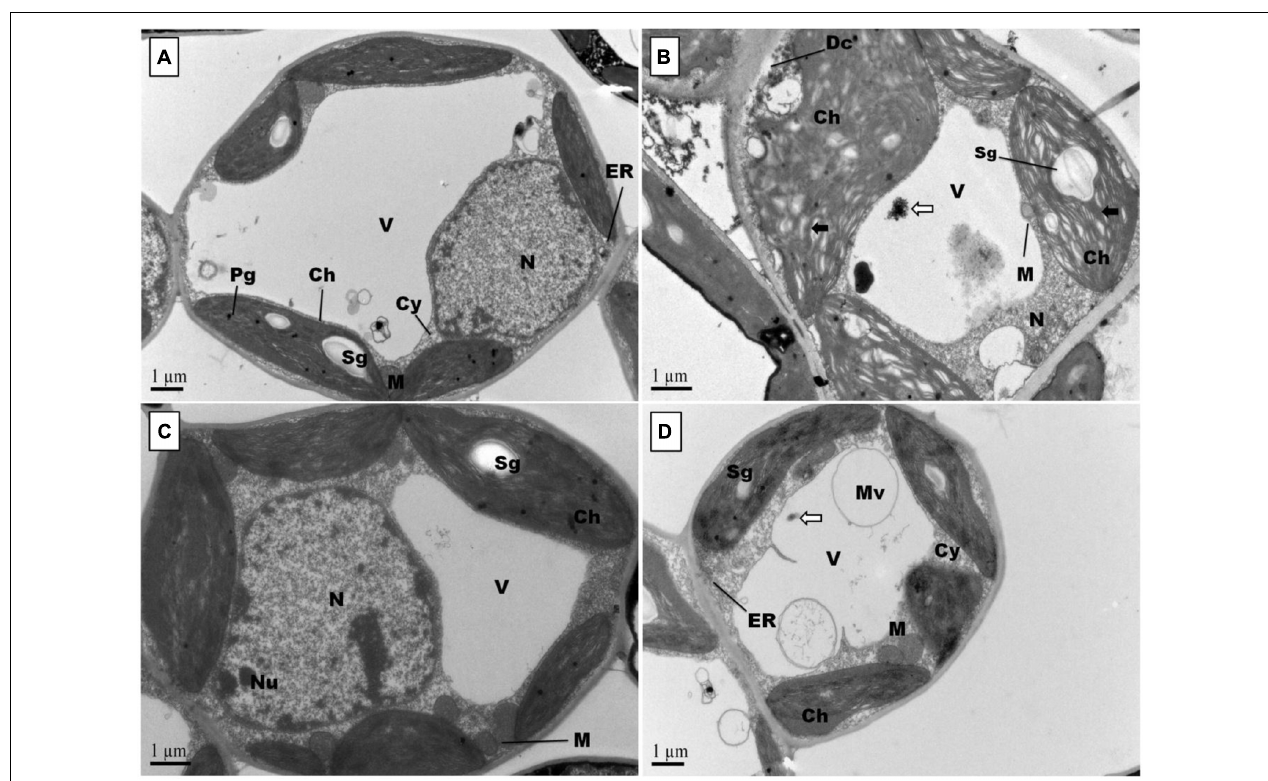
FIGURE 4 | Effects of Pb and GSH on ultrastructure of upland cotton terminal leaves. Transmission electron micrographs represent leaf cell morphology of control (A) , 500 µ M Pb (B) , 50 µ M GSH (C) and 500 µ M Pb + 50 µ M GSH (D) in cotton seedlings. In control cells (A) , cytoplasm (Cy) contained large central vacuole (V), nucleus (N) and well developed chloroplasts (Ch) with starch grains (Sg) and plastoglobuli (Pg). Rounded mitochondria (M) and endoplasmic reticulum (ER) can also be detected. After Pb exposure (B) , chloroplasts were highly dilated and granal stacks, represented by black arrow ( → ), were broken. Similarly, electron dense particles and cell debris, represented by white arrow ( ⇐(cid:72) ), was accumulated in the vacuole. GSH-treated leaf cells (C) possessed large chloroplasts, nucleus, nucleolus (Nu), and number of mitochondria were located in between chloroplasts. In GSH + Pb group (D) , chloroplasts were dilated but still intact. Moreover, large vacuole with multivesicular structure (Mv), endoplasmic reticulum and nucleus with nucleoli (Nu) were present also.